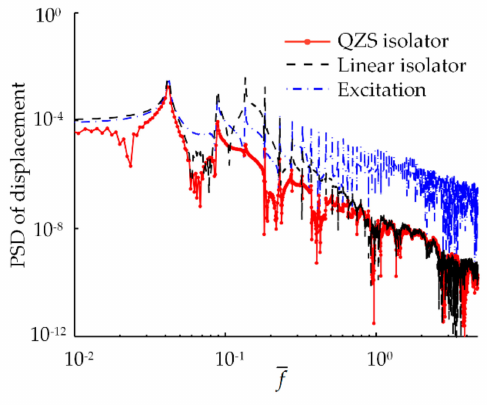
Figure 18. Power spectral density under random excitation.